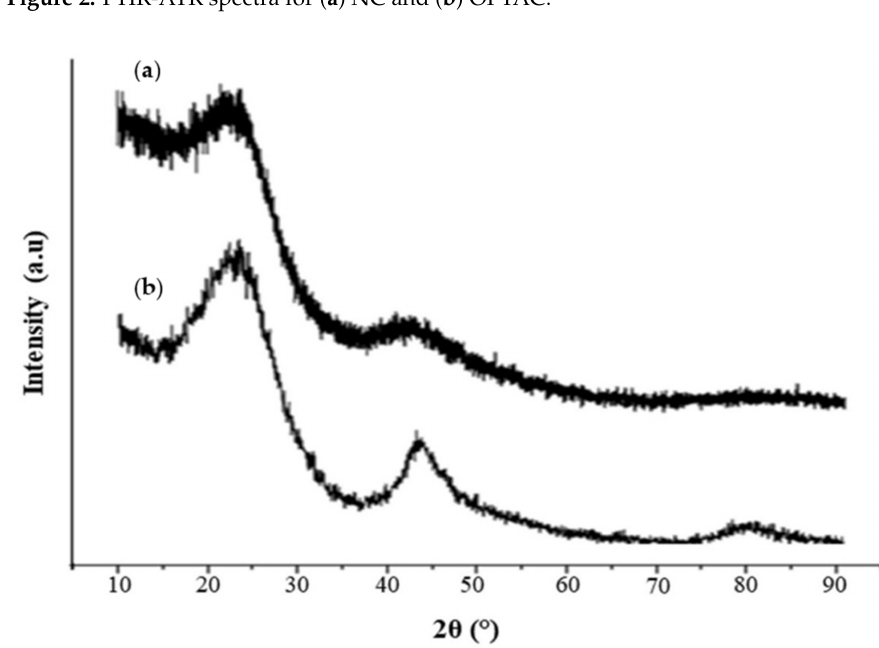
Figure 3. X-ray diffraction patterns of ( a ) NC and ( b )